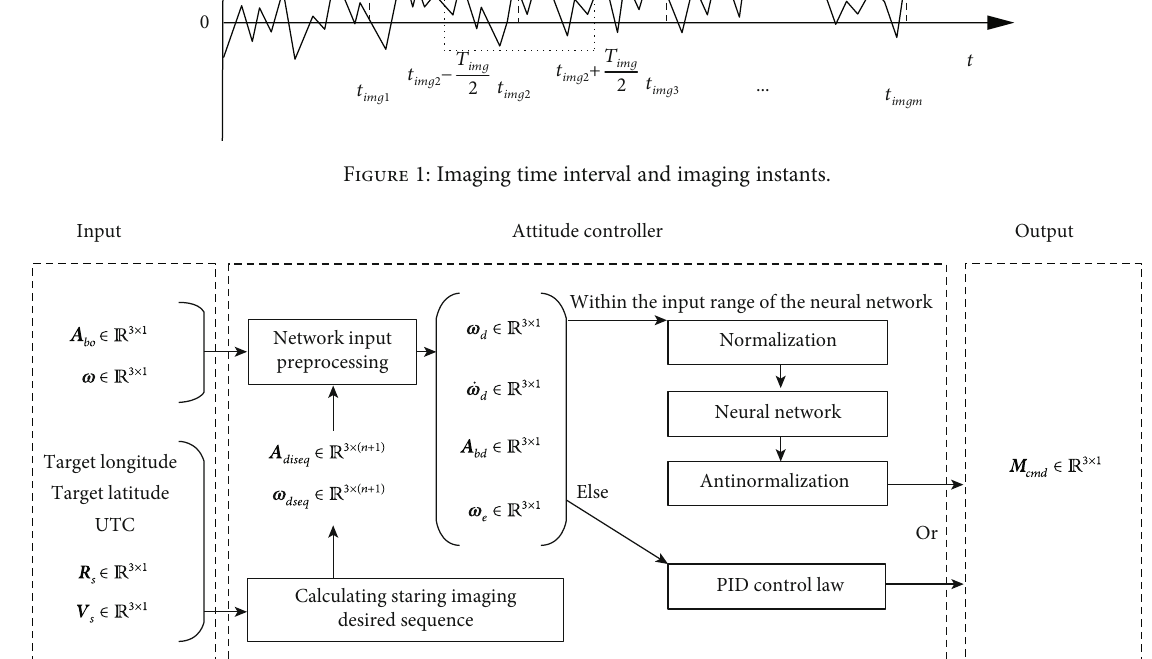
Figure 2: The structure of the attitude